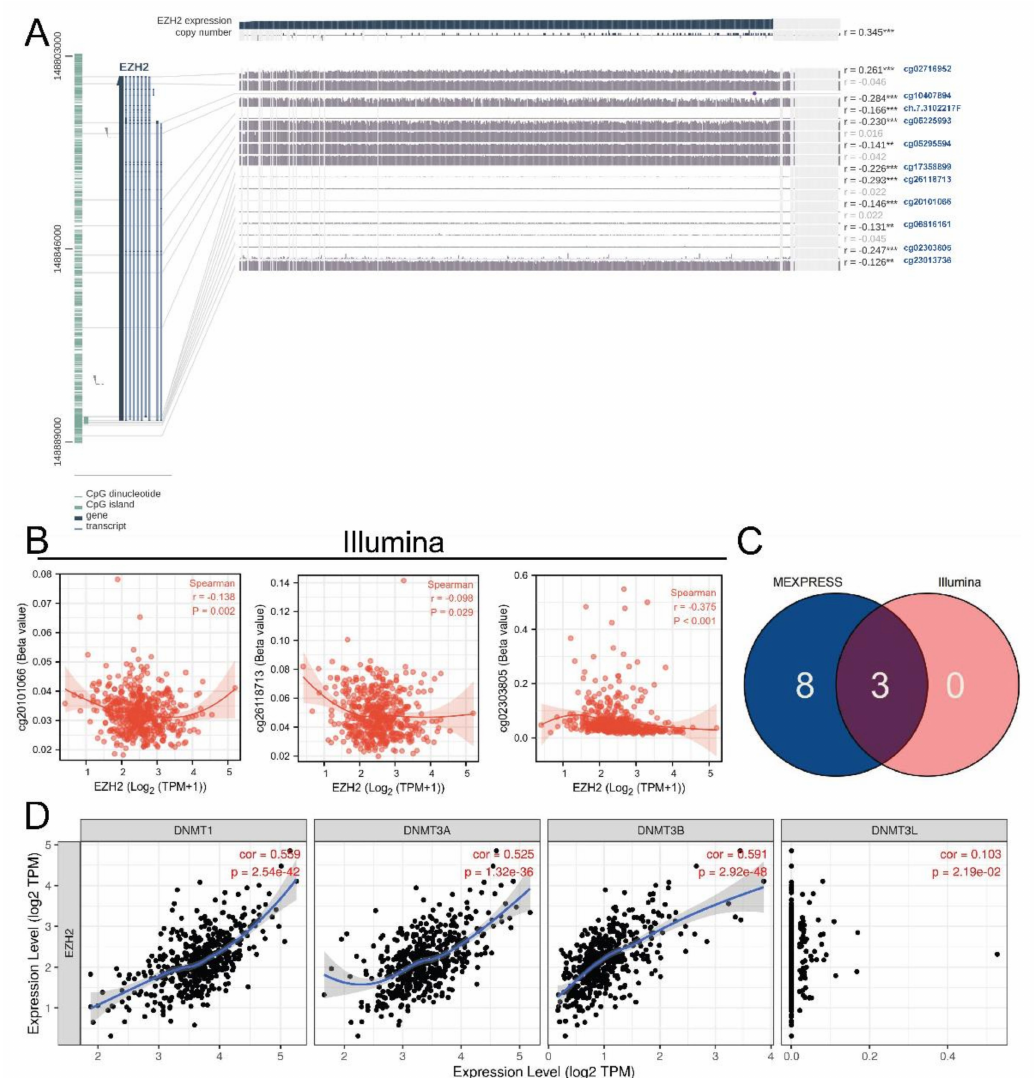
Figure 5. Associations between EZH2 expression and DNA methylation modification. Associations between EZH2 expression and methylation CpG sites in ( A ) MEXPRESS and in ( B ) Illumina. ( C ) Venn diagram indicates the shared methylation CpG sites from MEXPRESS and Illumina. ( D ) Associations between EZH2 expression and DNMTs. p -values < 0.01, and 0.001 were presented as “**”, and “***”,